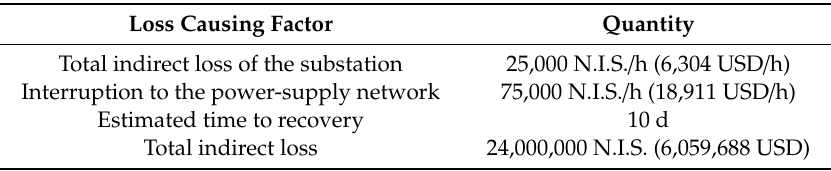
Table 4. Total Indirect Loss to Substation.